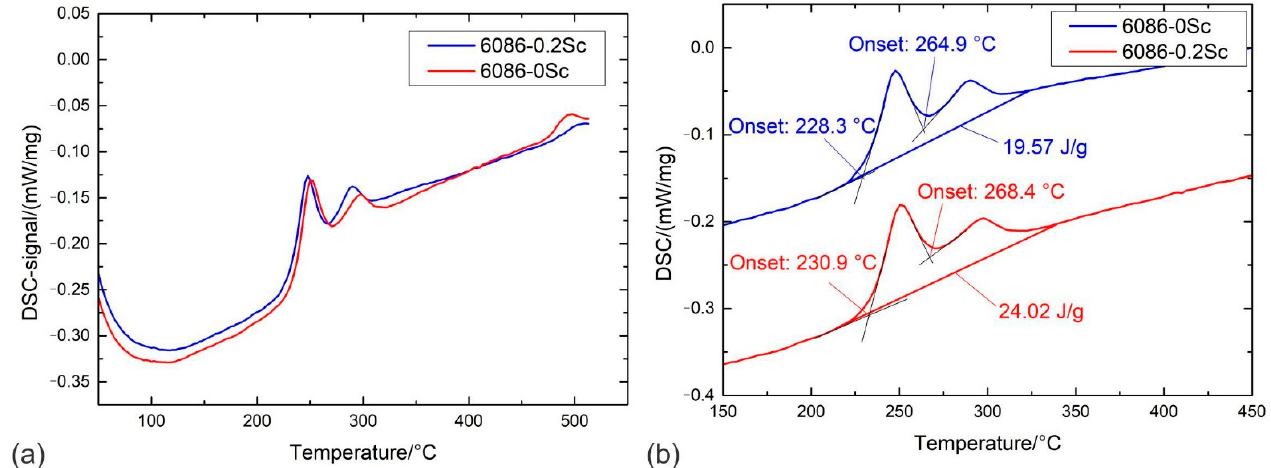
Figure 15. DSC heating curves for the alloys 6086-0Sc and 6086-0.2Sc. The initial condition was homogenisation for 6 h at 520 °C. ( a ) The whole range, ( b ) limited range with onset temperature and enthalpies of precipitation.